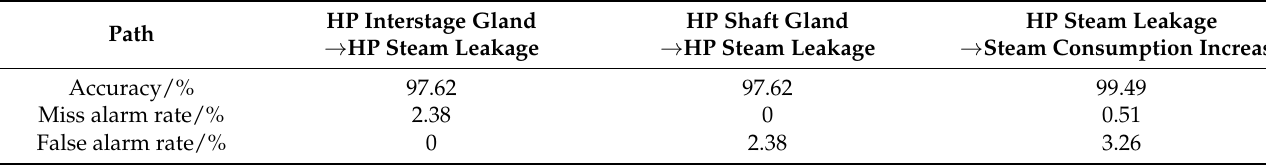
Table 2. Intermediate pressure (IP) fault propagation inference